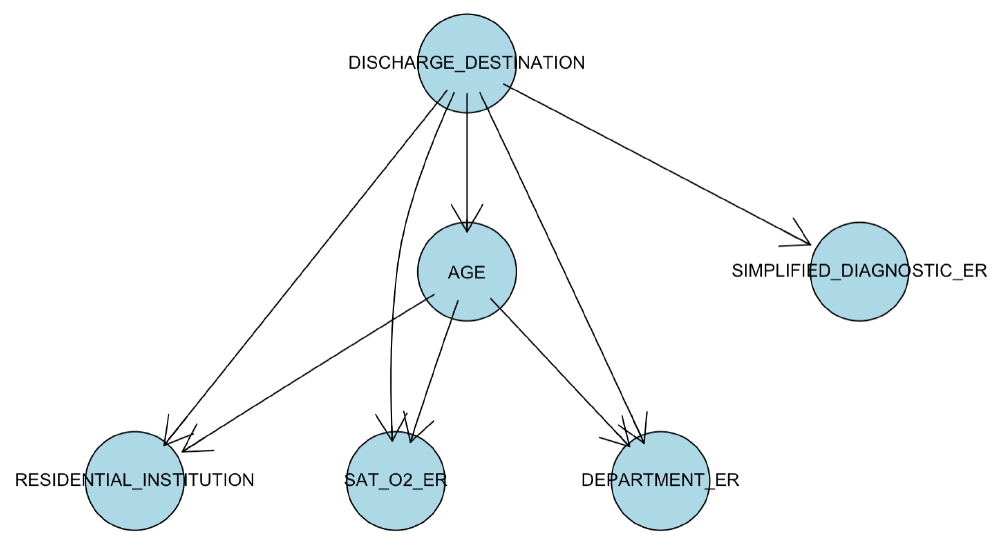
Figure 9. Tree augmented naive Bayes. The age was discretized considering as the cut-off values of 60 and 75 years and of 92% and 95% for O 2 saturation.